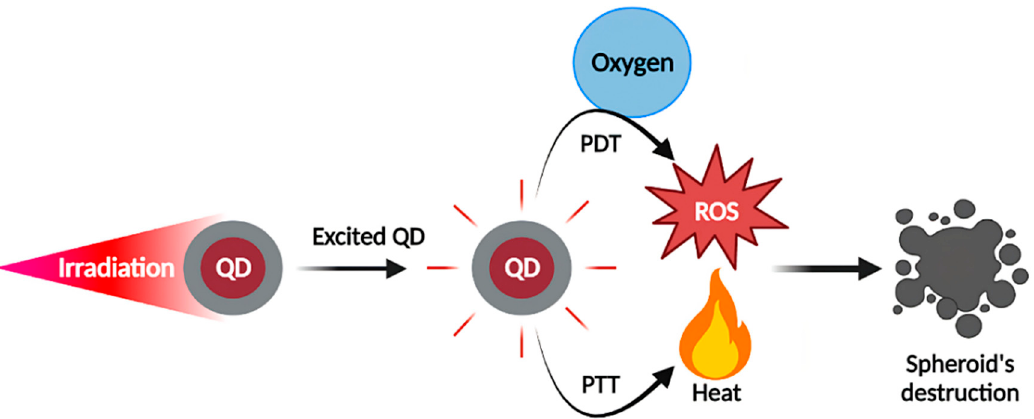
Figure 4. QDs as photosensitizers for photodynamic therapy or photothermal agents for photothermal therapy on spheroid models. Irradiation of QDs-loaded spheroids allows the production of ROS or heat (depending on the chemical properties of QDs) to mediate spheroid destruction by PDT or PTT,